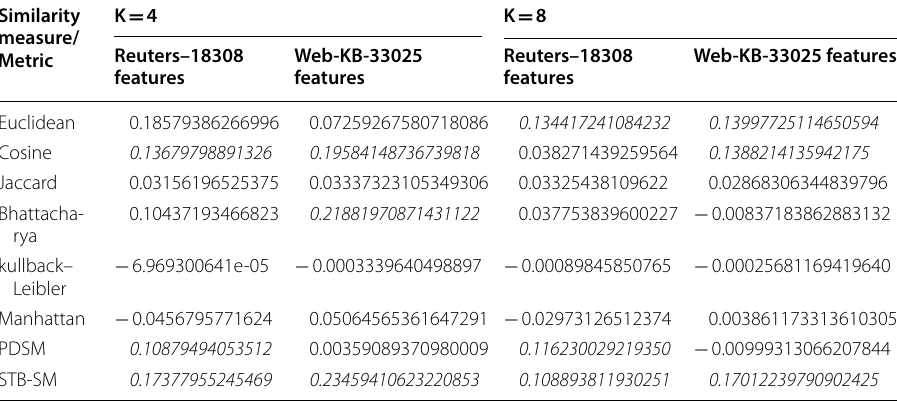
Italic values indicate the highest values that top measures achieved for corresponding evaluation metrics